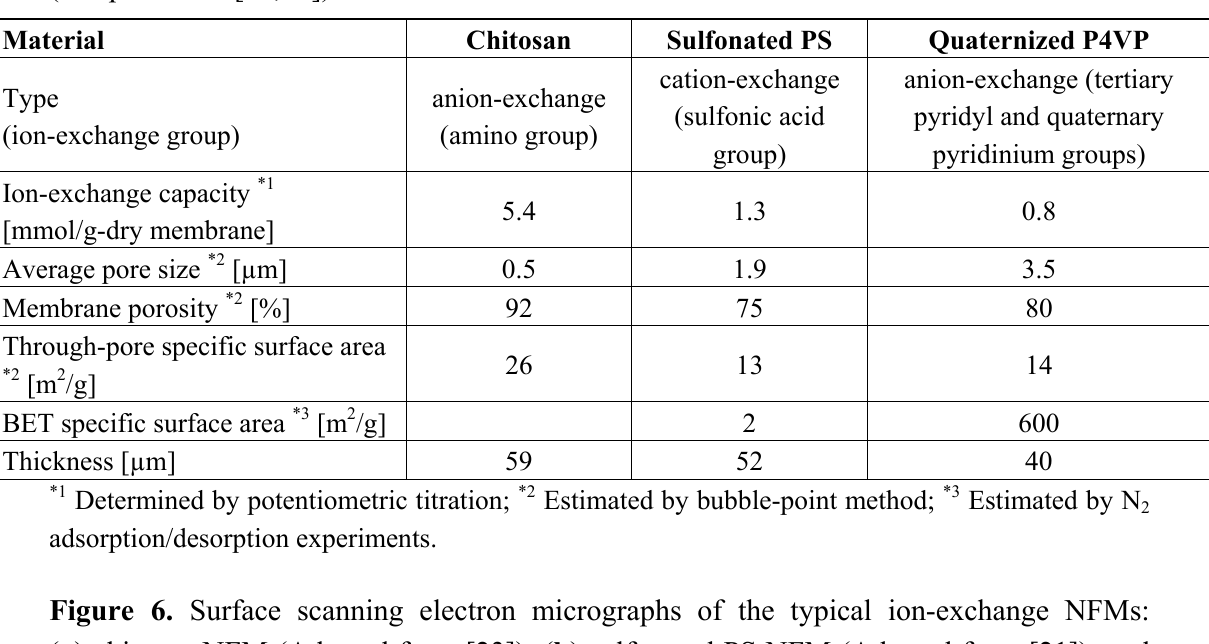
Table 2. Physicochemical properties of ion-exchange nanofibrous membranes (NFMs) (Adapted from [21,23]).